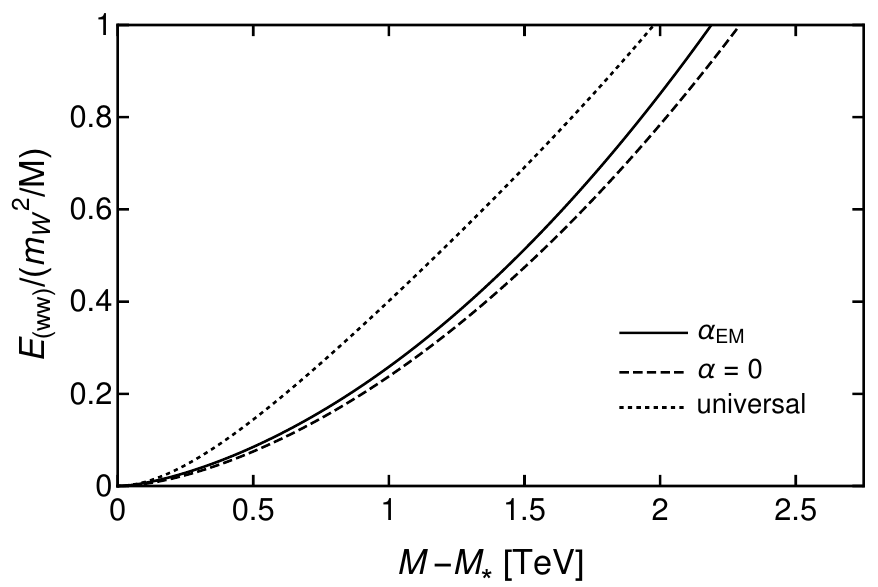
Figure 6 . The binding energy E of the wino-pair bound state as a function of the di(cid:11)erence ( ww ) between the wino mass M and the unitarity mass M (cid:3) . The binding energy is shown for (cid:11) = 1 = 137 (solid curve), for which M (cid:3) = 2 : 39 TeV, and for (cid:11) = 0 (dashed curve), for which M (cid:3) = 2 : 88 TeV. The universal approximation in eq. (3.17), with the Pad(cid:19)e approximant for a 0 ( M ) in eq. (3.13), is shown as a dotted